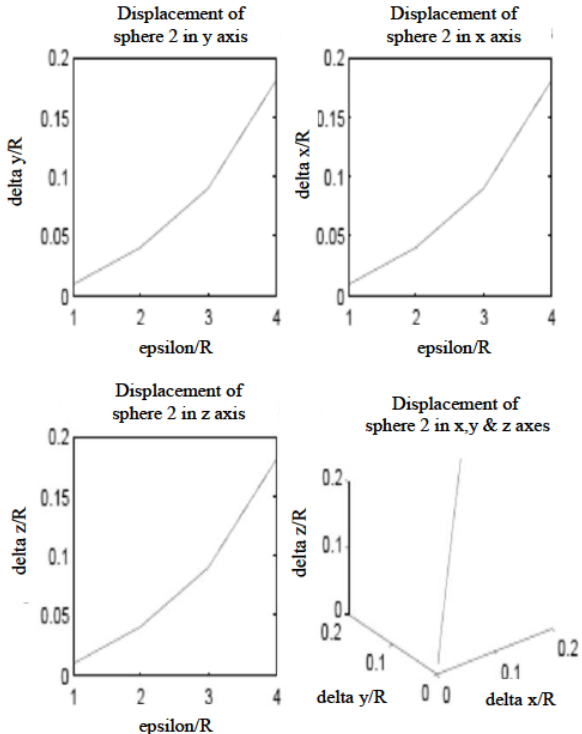
Figure 6: Dimensionless displacement of the second sphere in a complete cycle along the axes of x, y, z